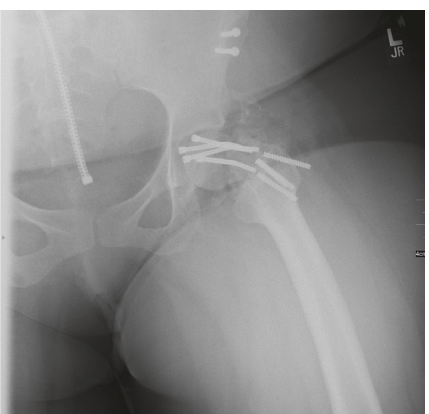
Figure 4: Anteroposterior radiograph demonstrating hardware fatigue and breaking of